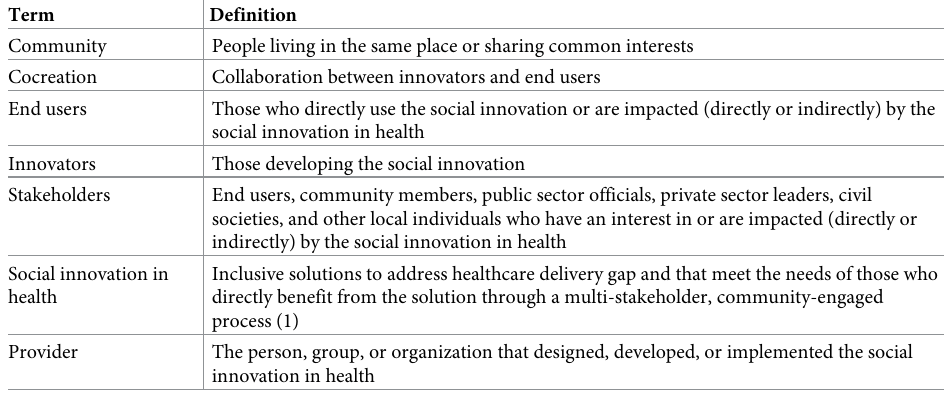
Table 1. Terms and definitions for our SIFHR